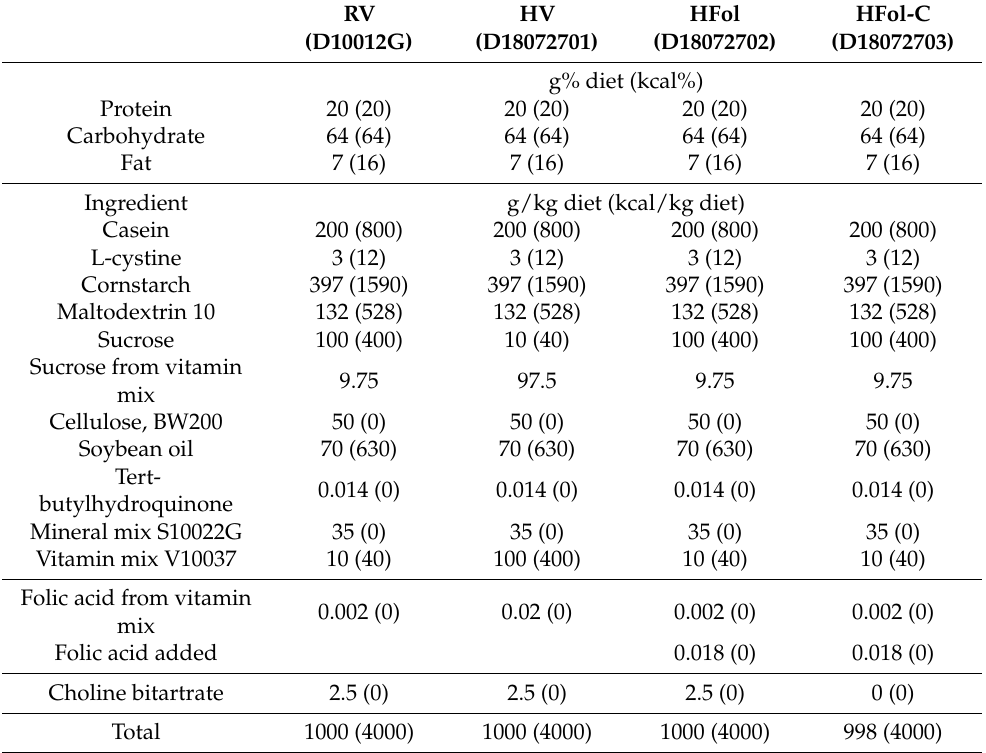
Table 1. Composition of gestational